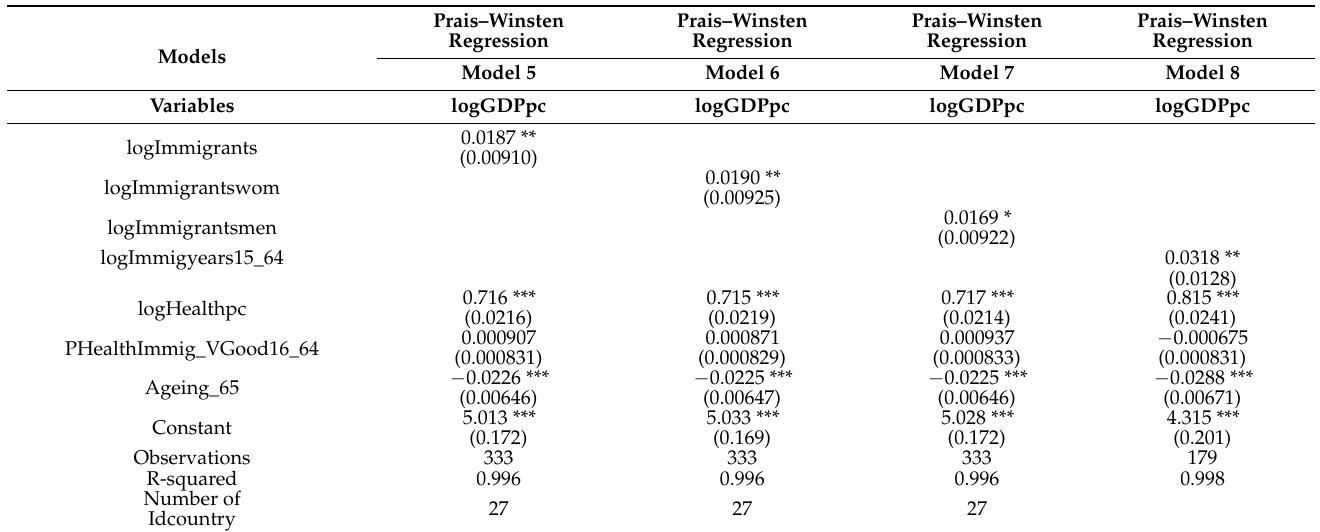
Table 3. Prais–Winsten Regression models with different variables representing